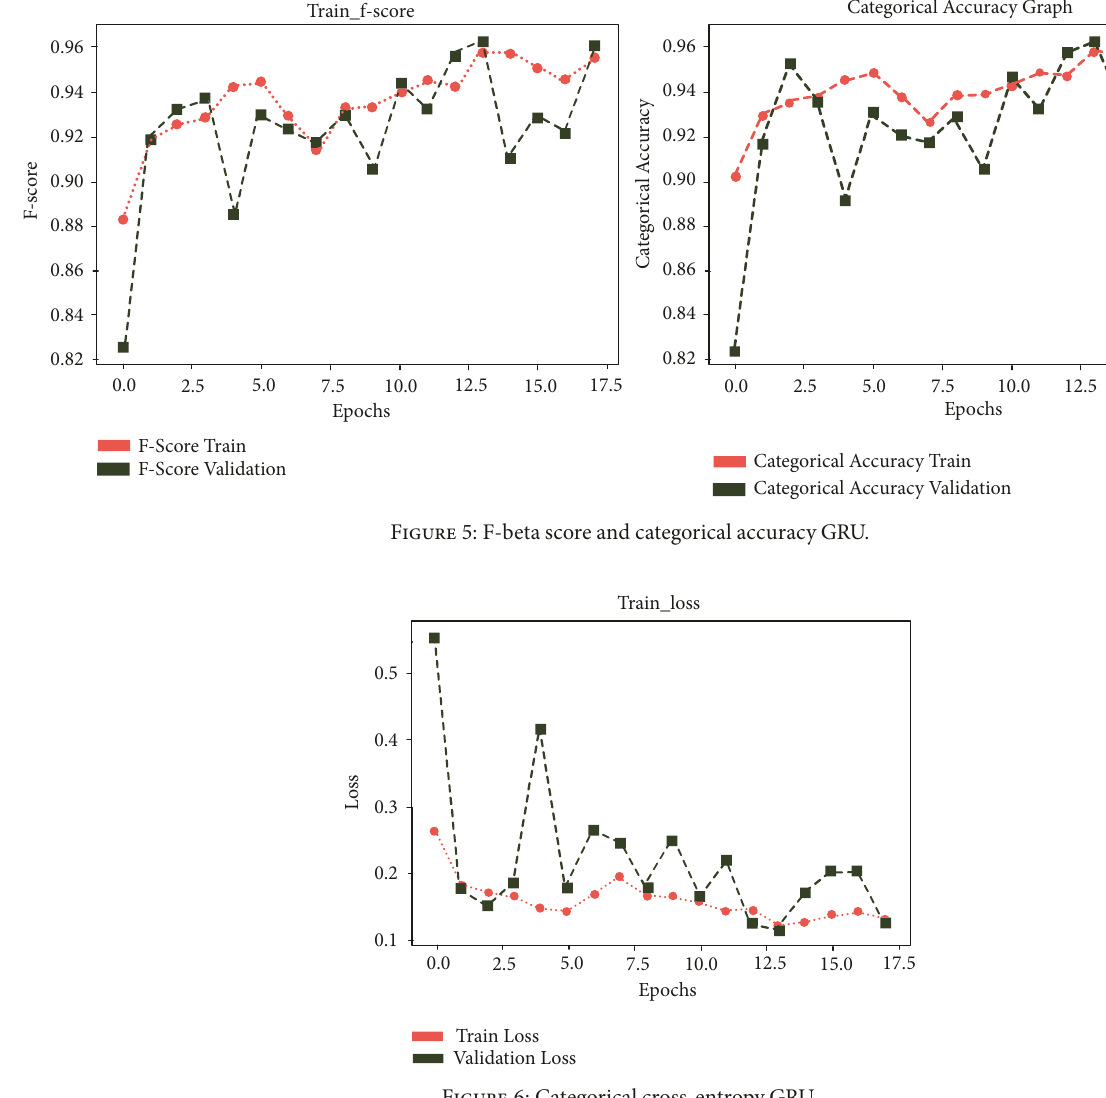
Figure 6: Categorical cross-entropy